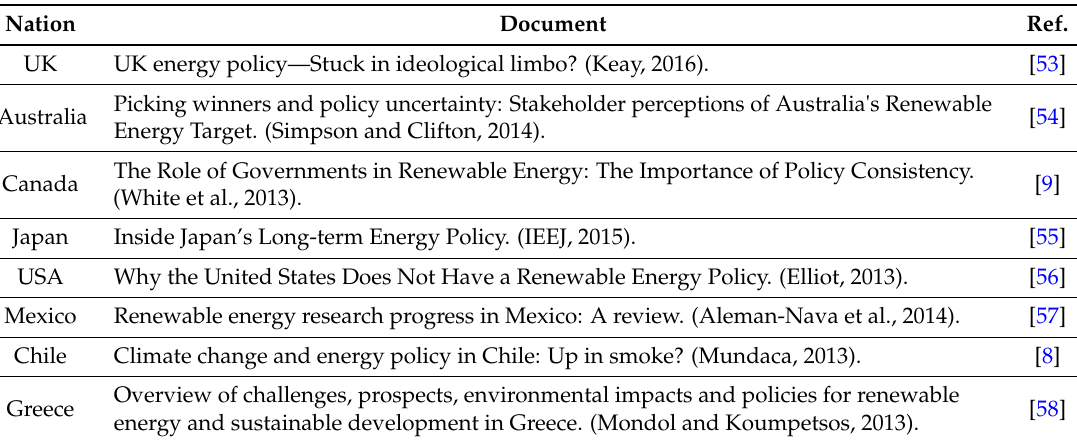
Table 6. Academic RE policy review